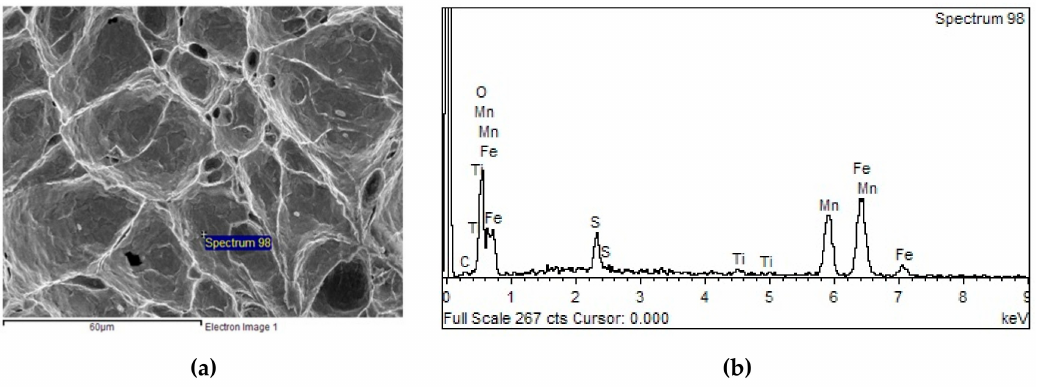
Figure 7. ( a ) Particles on the fracture, sample X7, T Q = 946 ◦ C, N f = 6.2; ( b ) EDX spectrum from the particle in Figure